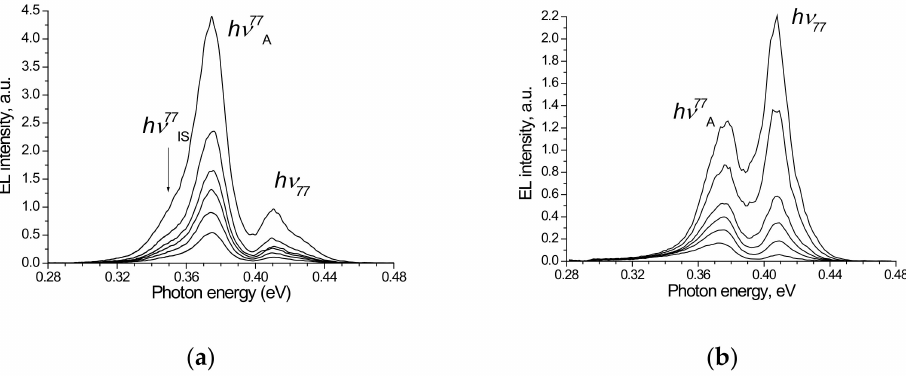
Figure 4. EL spectra obtained for different values of the driving current ( i = 20, 30, 40, 50, 75 and 100 mA) at forward bias applied at T = 77 K: ( a ) for samples A and B; ( b ) for sample